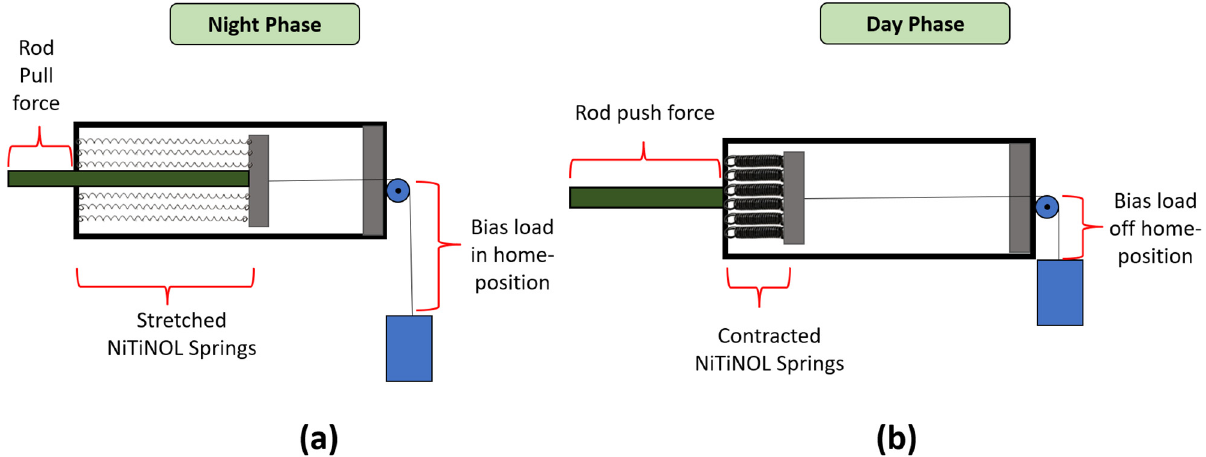
Figure 2. The solar-driven SMA thermomechanical actuator actuation cycles at ( a ) daytime and ( b ) nighttime.